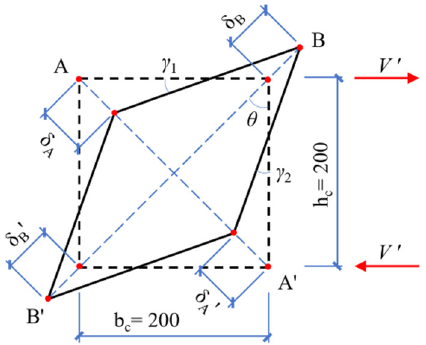
Figure 12. Shear deformation calculation diagram (unit: mm).